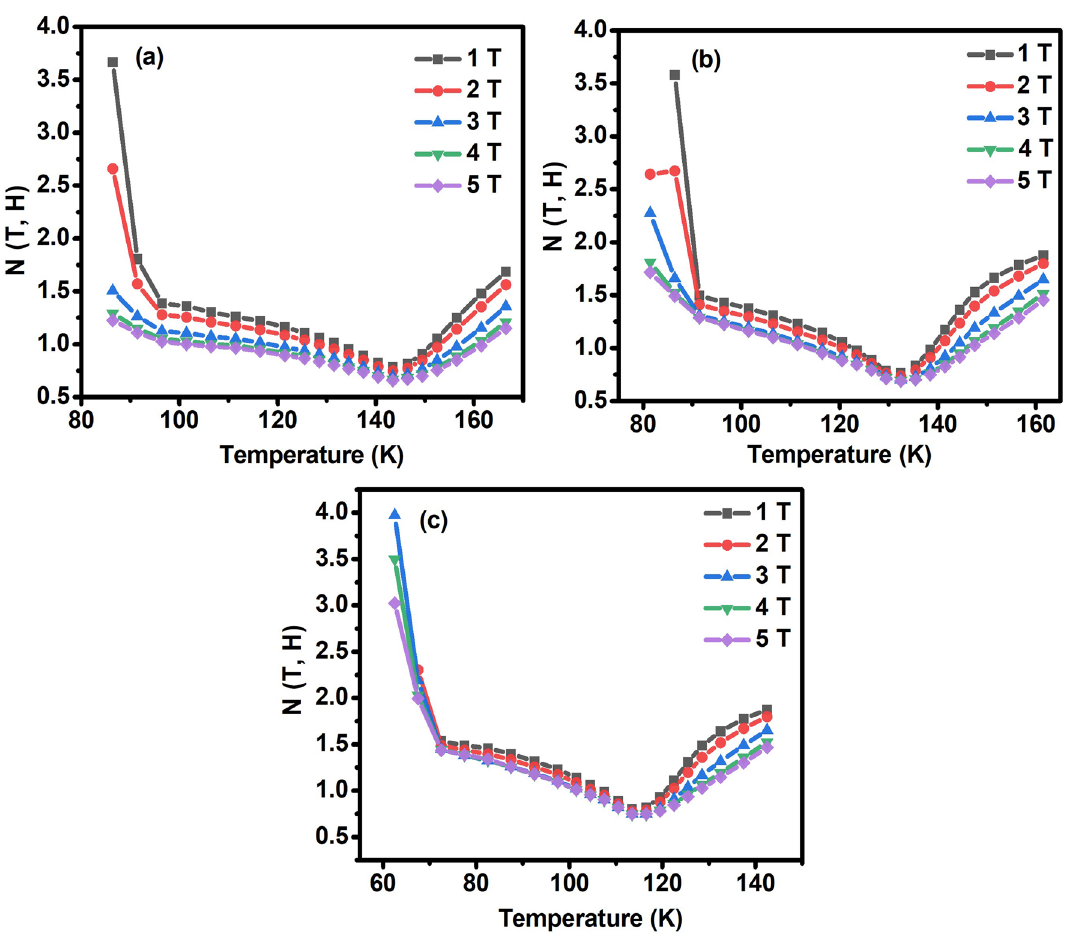
Figure 8. Temperature dependence of the exponent N (T, H) at various magnetic field for the ( a ) ENMO, ( b ) GNMO, ( c ) TNMO samples at different magnetic